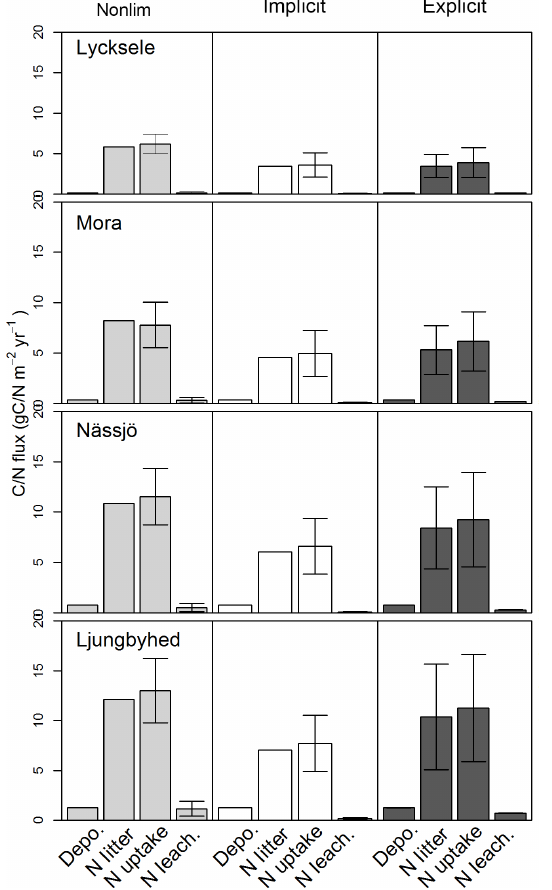
Figure 3. Soil N fluxes for the nonlim (grey columns), implicit (white), and explicit (black) model approaches; same color scheme used for the other figures. Presented are the major N inputs (N de- position, total N litter production, added to the soil litter pool by fresh litter), and outputs (N uptake from the plant or ECM, N leach- ing). Error bars indicate the 90th percentile of accepted model runs (posterior). Units for N are gNm − 2 yr − 1 and gCm − 2 yr − 1 for C.